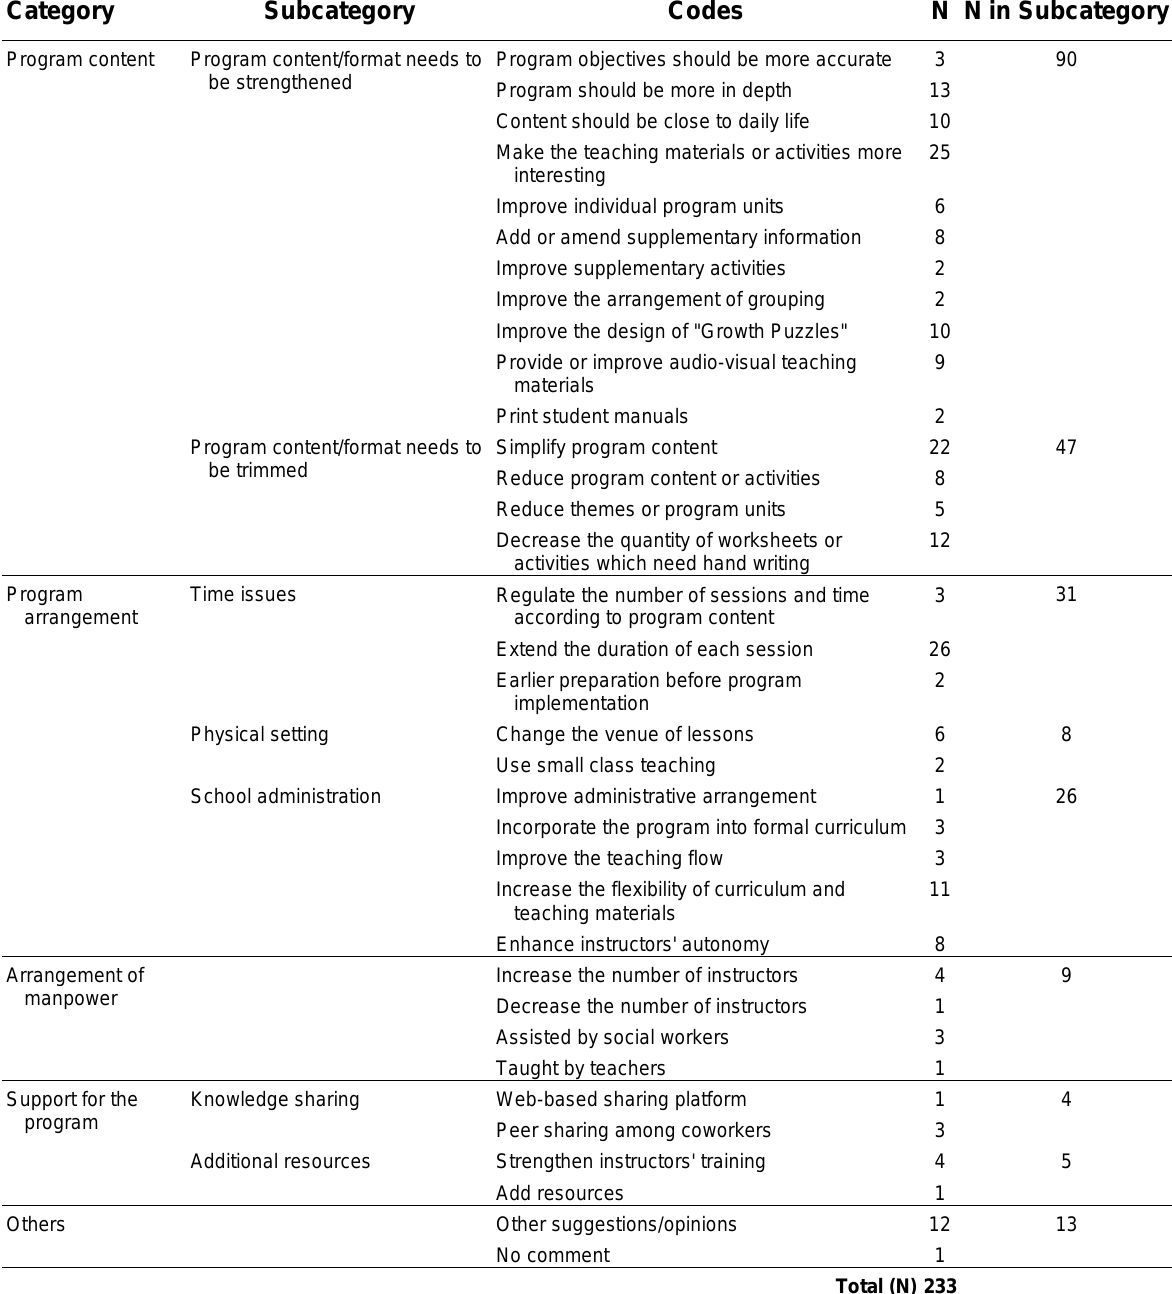
Summary of the Program Implementers' Comments on the